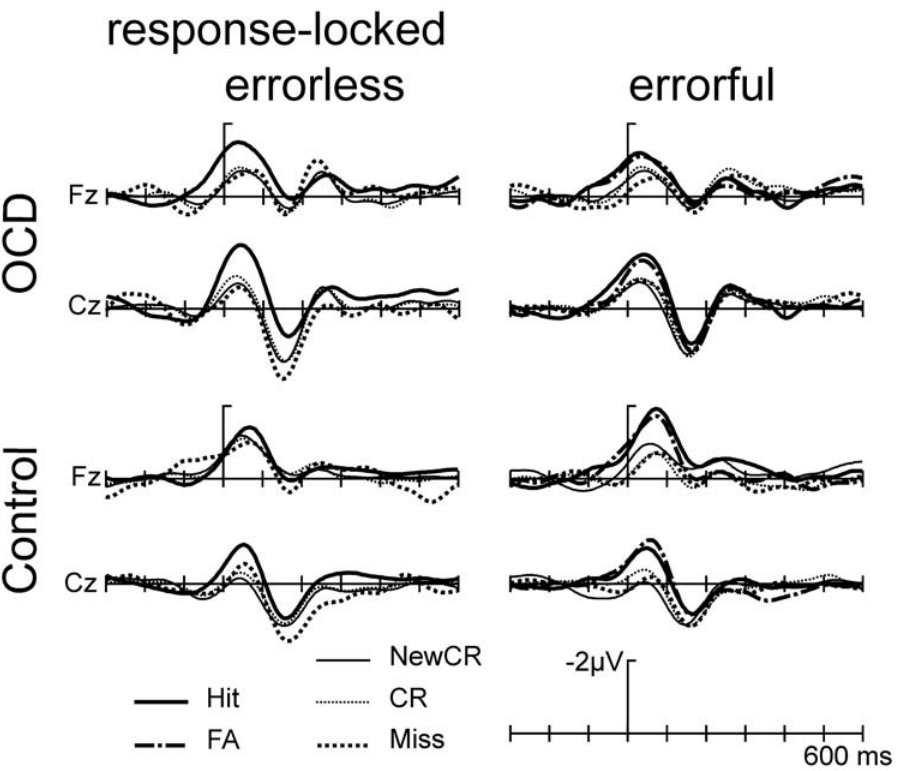
Figure 1. Response-locked potentials for OCD- and control-group. Response-locked ERPs (negativity is plotted up and each hash mark represents 100 ms of activity in this and in the following figures) of OCD patients (upper panel, N=16) and control group (lower panel, N=16). Hits related to both learning conditions and errorful false alarms result in an increased negativity compared to misses and both correct rejections. For the errorless mode (left panel) this is enhanced for OCD as compared to control group. For the errorful condition the opposite is true (most prominent at Fz).